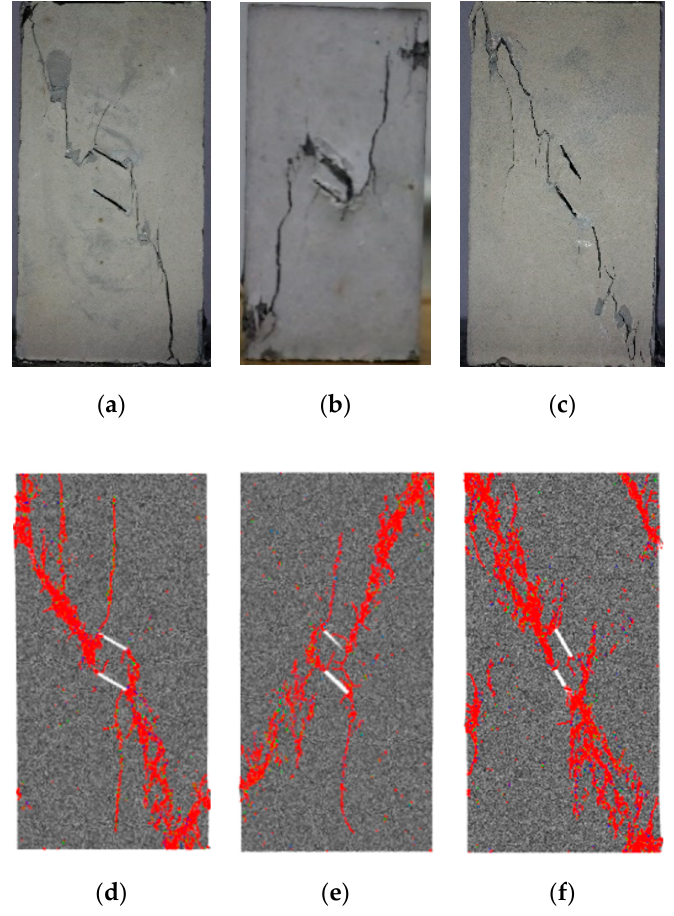
Figure 2. Comparison of failure modes between laboratory experiment and numerical simulation. ( a ) α = 30°; ( b ) α = 45°; ( c ) α = 60°; ( d ) α = 30°; ( e ) α = 45°; ( f ) α = 60°. (Pictures a, b and c are experimental results, and pictures d, e and f are numerical results).